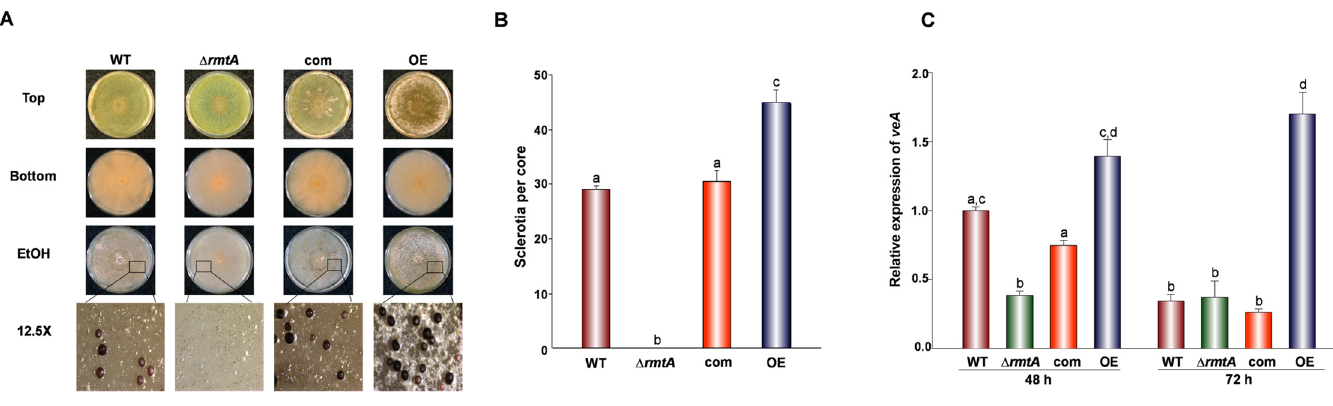
Fig 5. Effect of rmtA on sclerotial production on PDA. (A) A . flavus wild type (WT), Δ rmtA , complementation (com) and OE rmtA (OE) strains were point- inoculated on PDA medium and incubated for 9 days in the dark at 30°C. Photographs of cultures were taken before and after spraying 70% ethanol to remove conidia in order to improve visualization of sclerotia. Micrographs were obtained approximately 1.5 cm away from the center of the plate using a Leica MZ75 dissecting microscope at 12.5X magnification. (B) Quantification of sclerotia. A . flavus wild type, (WT), Δ rmtA , complementation (com) and OE rmtA strains grown on PDA medium for 24 days at 30°C. Sixteen millimeter cores were collected 1 cm away from the center. Number of sclerotia in each core were counted under a Leica MZ75 dissecting microscope. The experiment included 3 replicates. Error bars represent standard error. (C) qRT-PCR expression analysis of veA . A . flavus wild type (WT), Δ rmtA , complementation (com) and OE rmtA (OE) strains were inoculated in PDB stationary cultures (10 6 spores/ ml), and were grown for 48 and 72 h at 30°C. Error bars represent standard errors. Values were normalized to the expression levels in the wild type, considered as 1. Different letters on the columns indicate values that are statistically different (p <